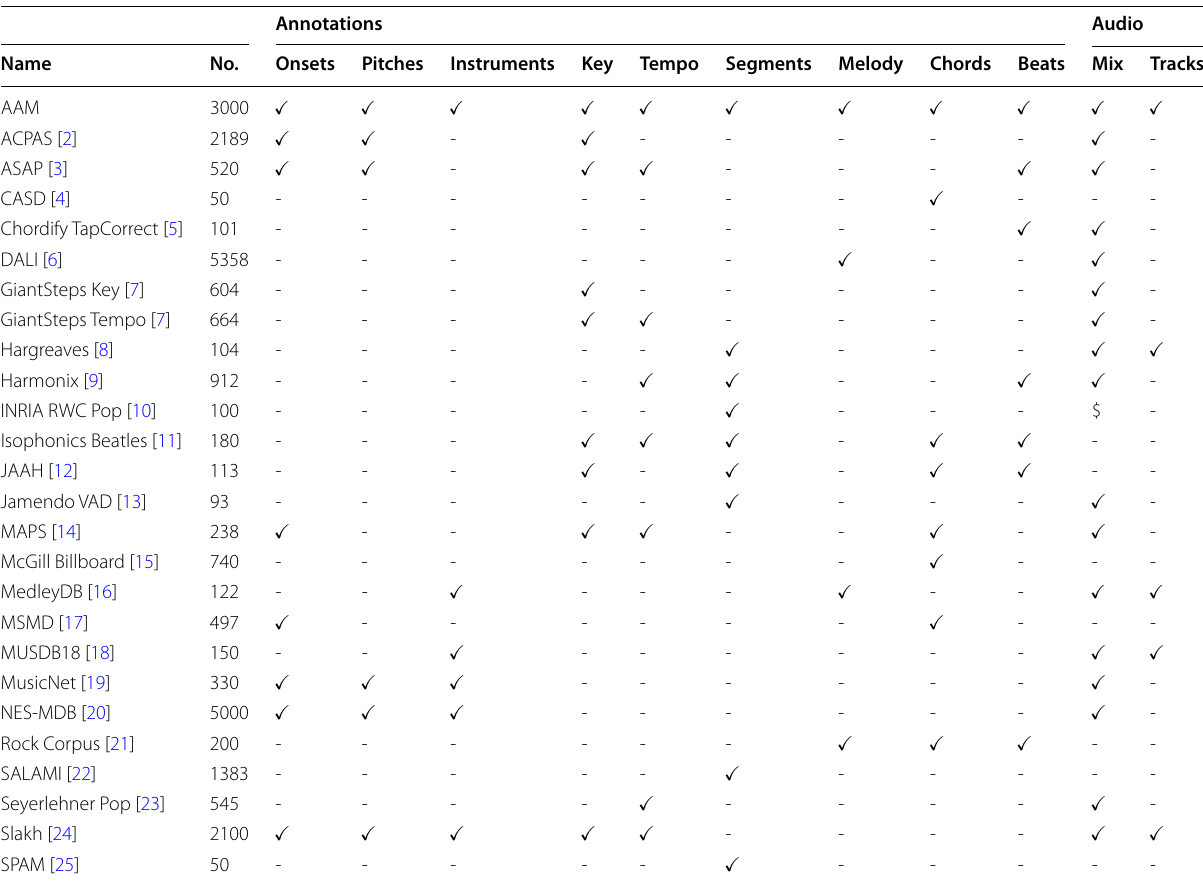
Table 1 List with selected state-of-the-art music datasets with distinct annotations. The $ symbol marks proprietarily licensed music tracks which have to be